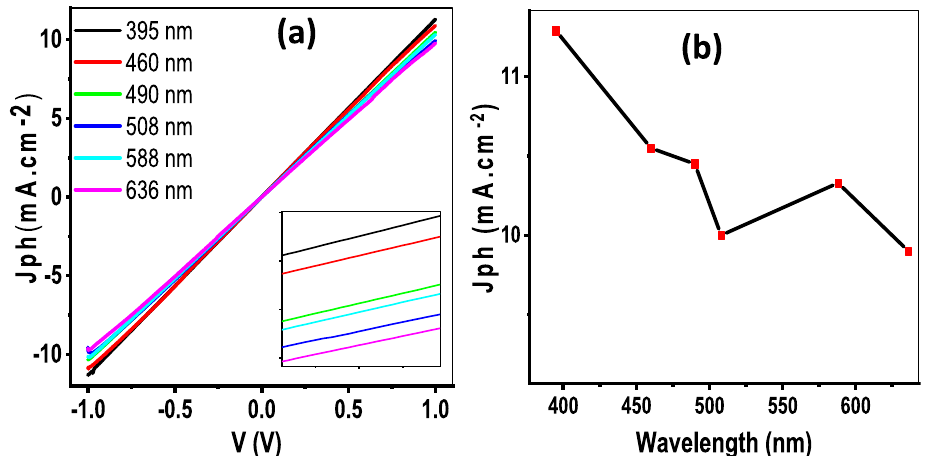
Figure 6. ( a ) The relation between voltage and Jph under monochromatic illuminated with different wavelengths and ( b ) V-Jph relation at 1.0 V for PAOT/TiO 2 /TiN